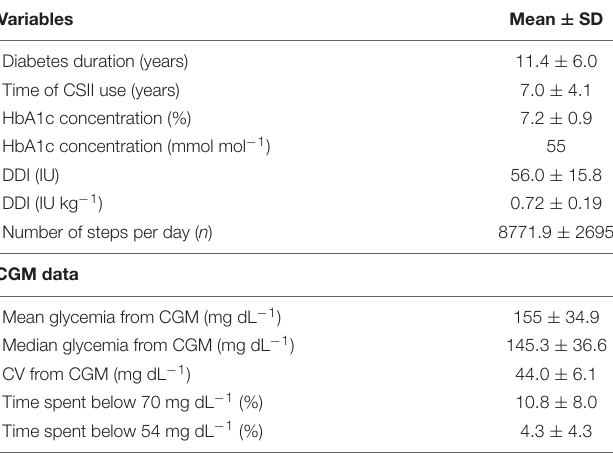
TABLE 3 | Clinical characteristics and selected parameters of continuous glucose monitoring in T1DM